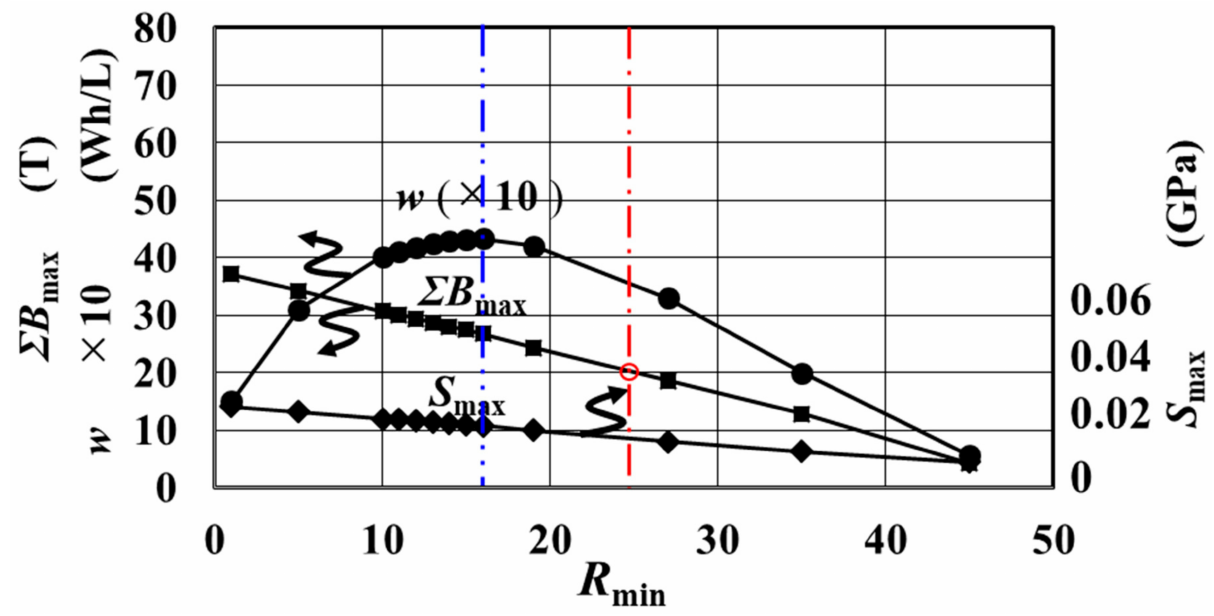
Figure 14. Variations in the electricity storage volume density w , S max , and Σ B max as a function of R min based on the magnetic flux density dependent j c displayed as curves ( b ) and ( c ) in Figure